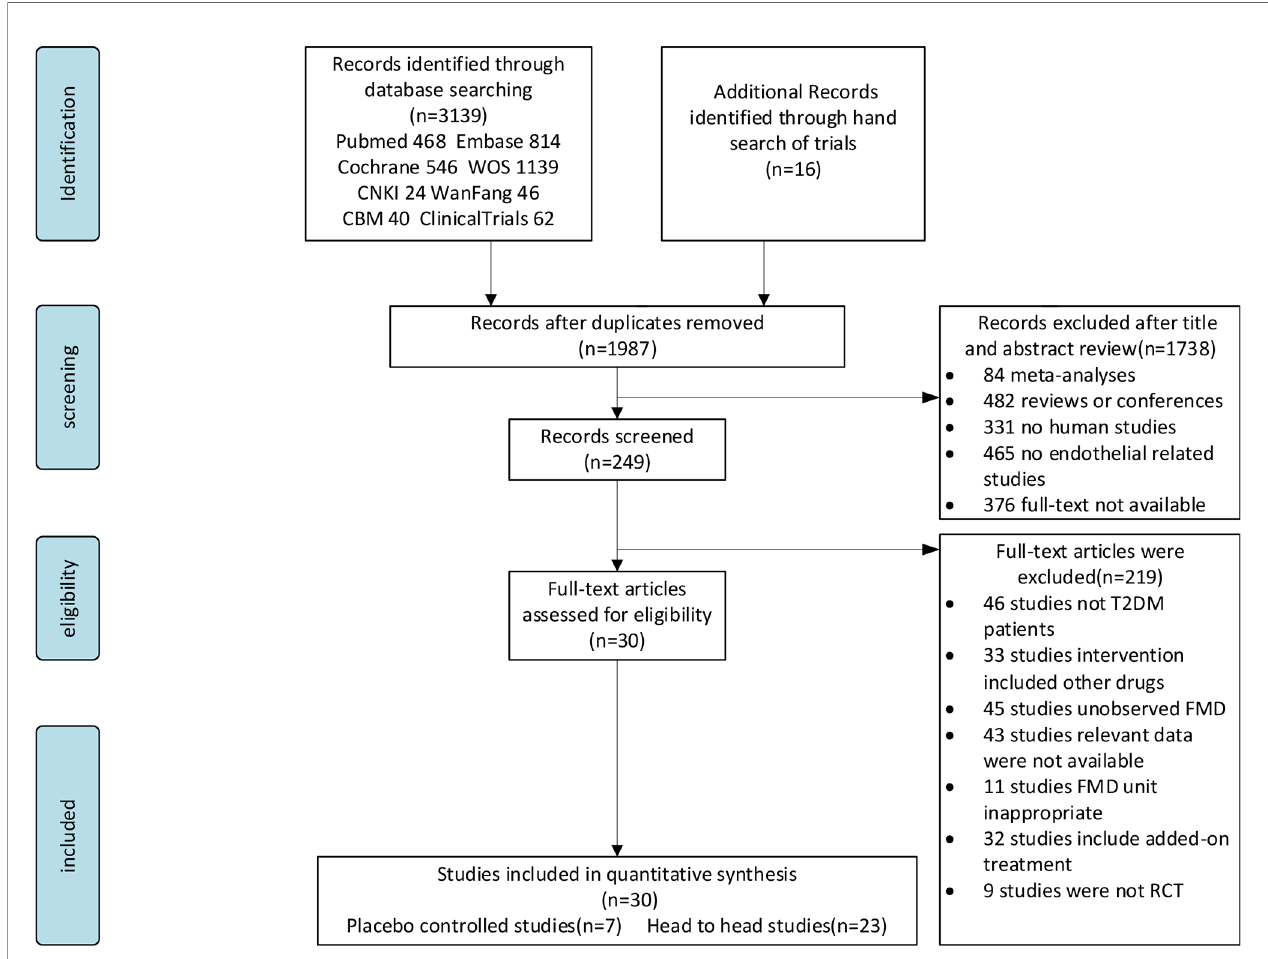
FIGURE 1 | Study selection fl ow